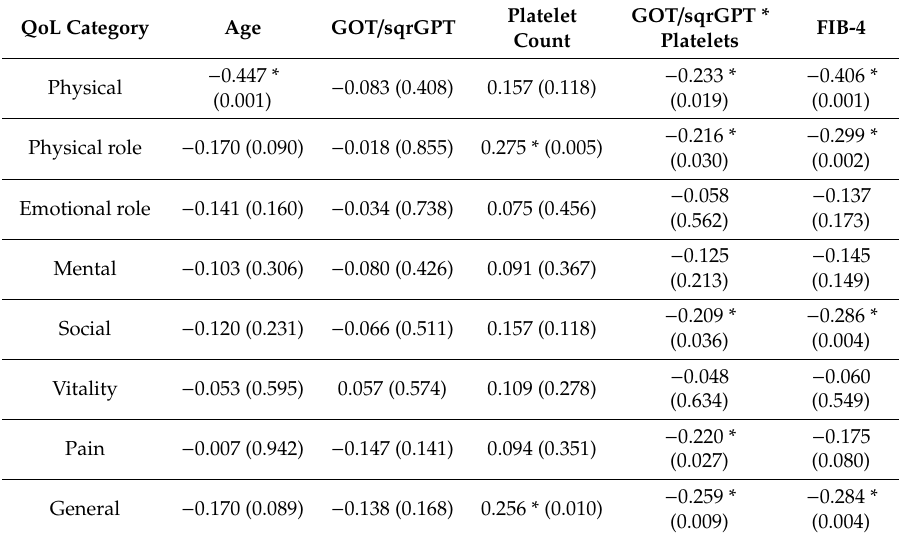
Table A2. Association between components of Fibrosis-4 (FIB-4) and the 8 categories of quality of life (QoL) in